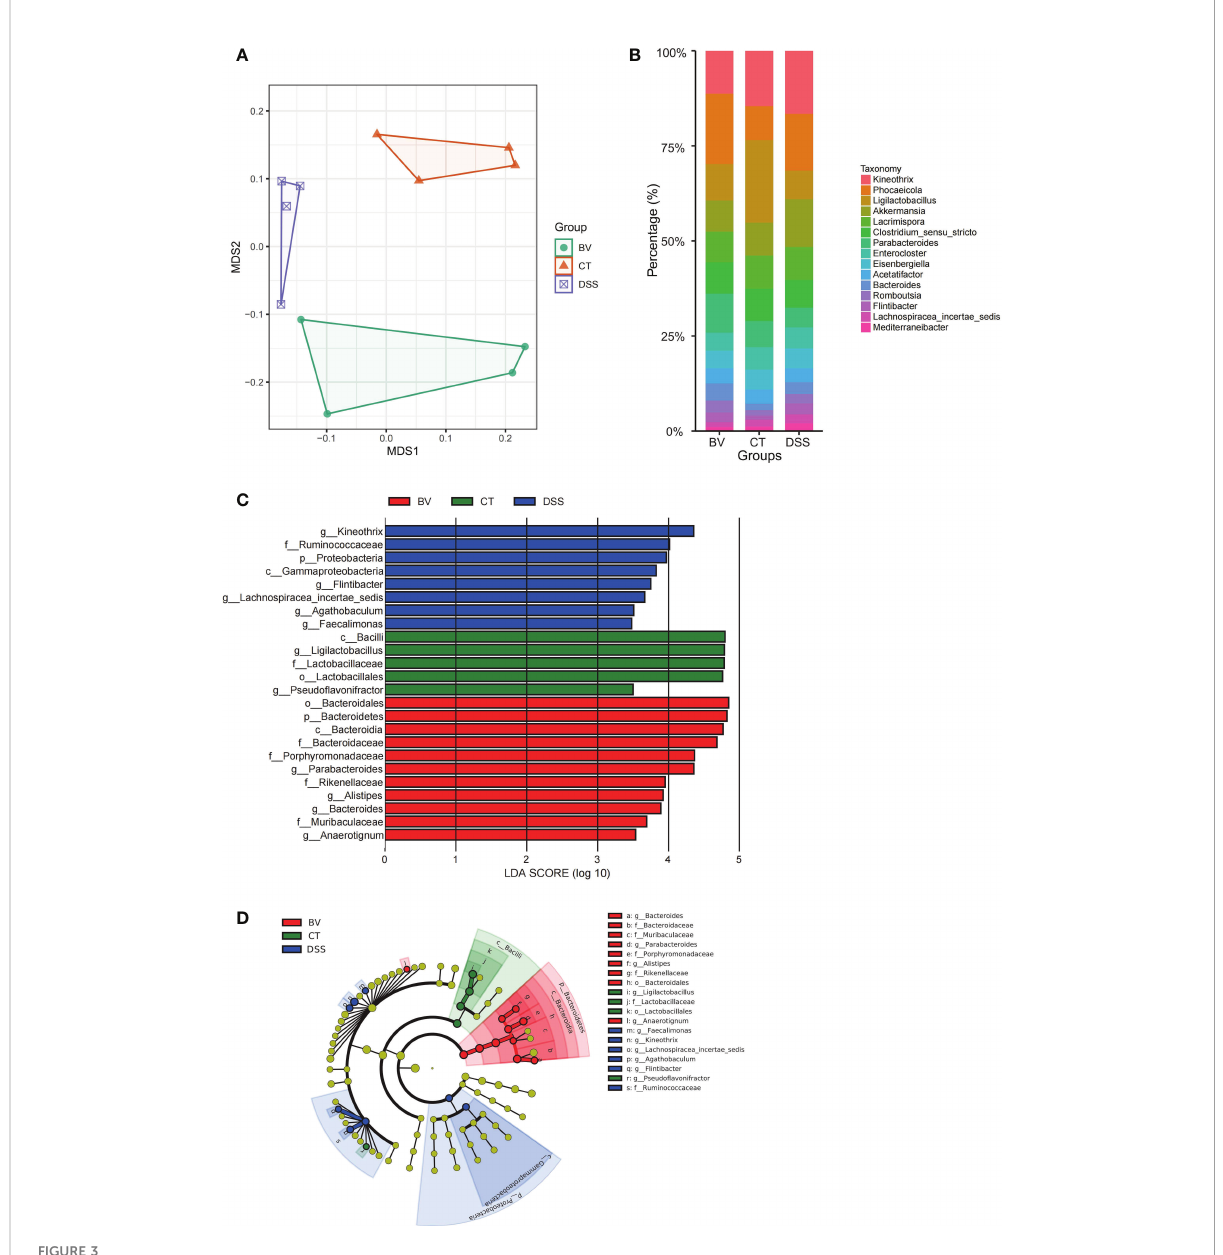
FIGURE 3 Effect of B. vulgatus Bv46 on intestinal microbiota composition in DSS-induced colitis mice. CT, DSS, and BV denote control (no DSS induction), DSS induction and treatment with phosphate buffer saline only, and DSS induction and treatment with B. vulgatus Bv46, respectively. (A) Ordination of microbial pro fi les using non-metric multidimensional scaling (NMDS) plotting. (B) Barplot analysis of the microbial compositional pro fi ling at the genus level (top 15). (C) Overrepresented bacterial taxa among groups determined by Linear discriminant analysis (LDA). (D) A cladogram of taxa shown in (C) (from phylum to